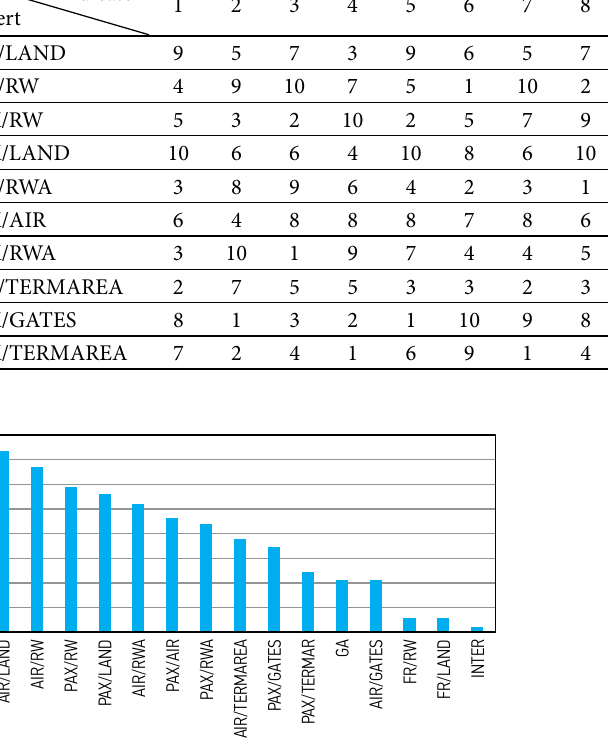
Fig. 2. Productivity indicators following first assessment Fig. 3. Productivity indicators following second assessment